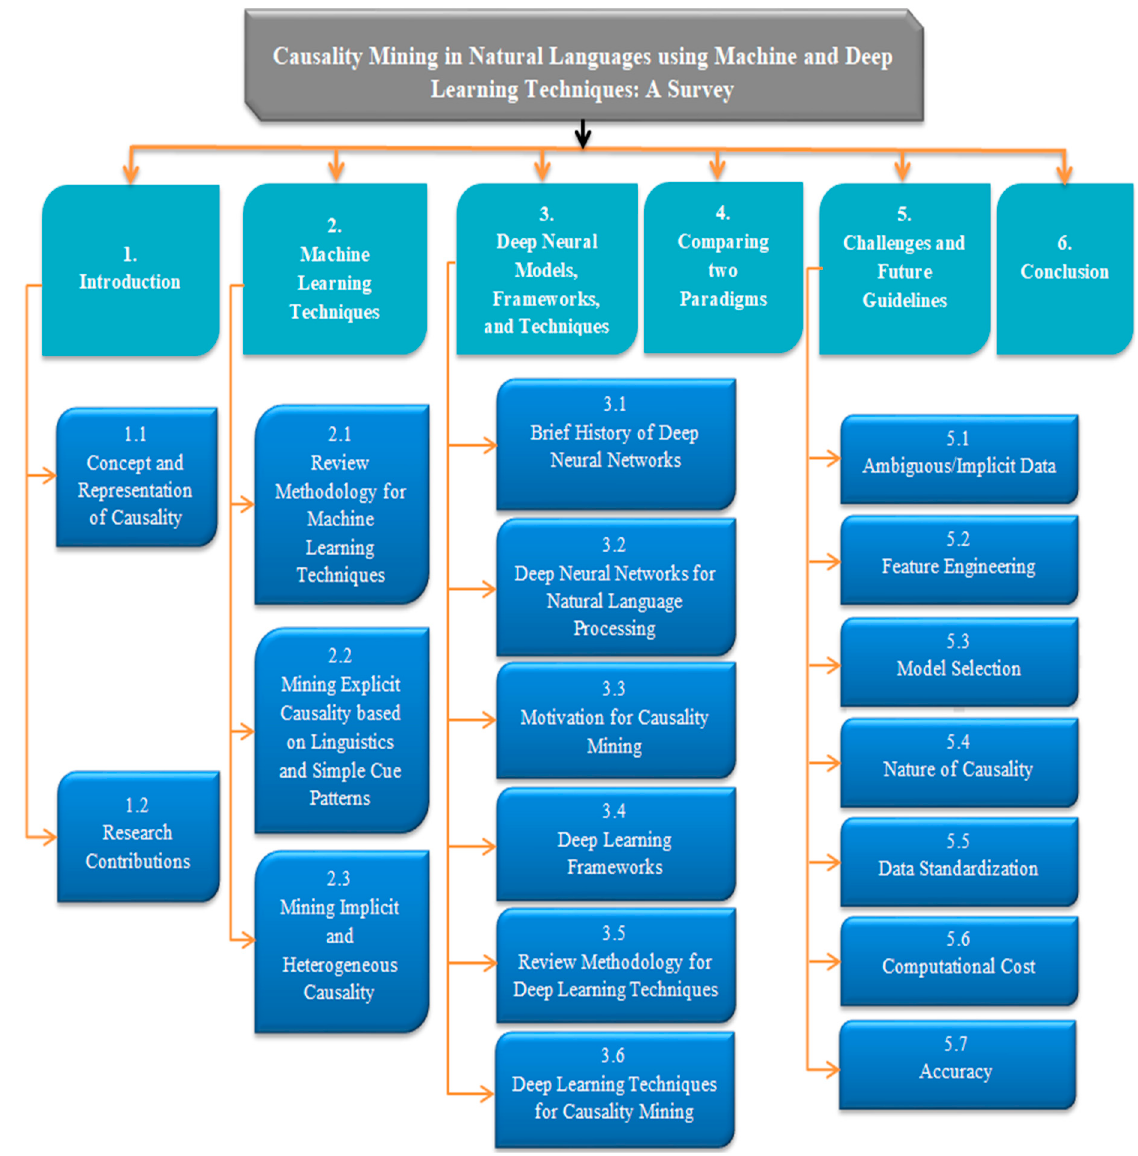
Figure 3. Organization of